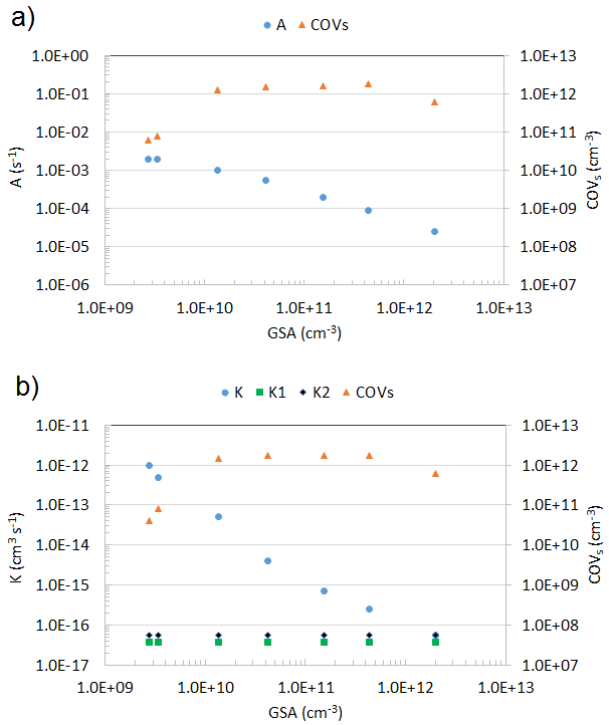
Figure 5. Nucleation coefficients as a function of GSA and COV s concentrations when the nucleation mechanism was ACT (a) , KIN and HET (b)